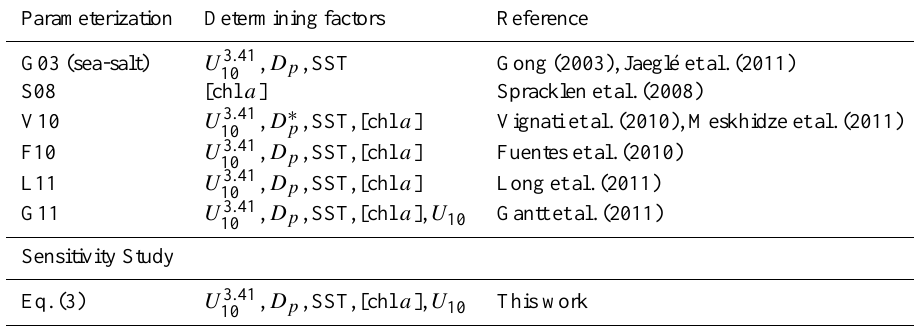
Table 1. Summary of sea-salt aerosol and marine POA emission schemes used in